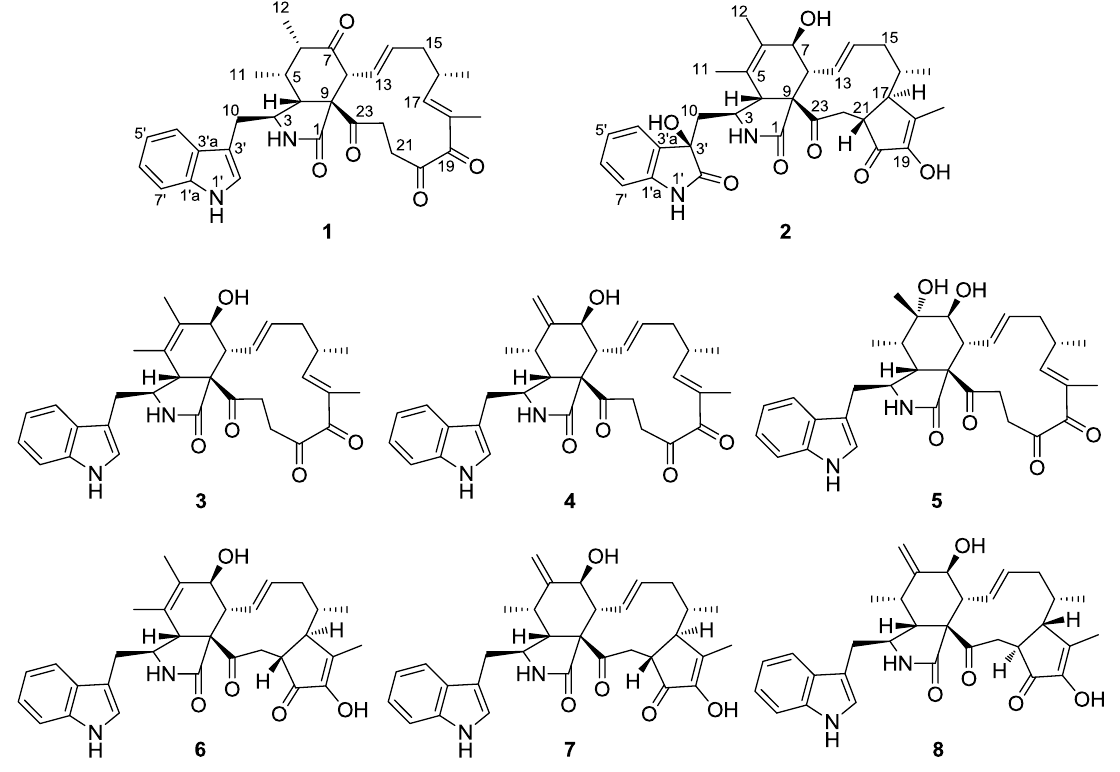
Figure 1. Structures of isolated Compounds 1 – 8 .